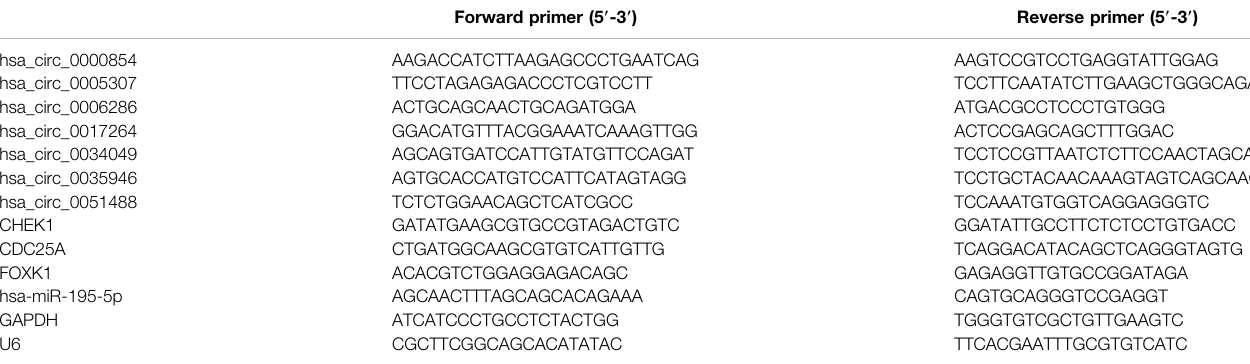
TABLE 2 | Primer sequences of circRNAs, miRNAs, and mRNAs used for qRT –